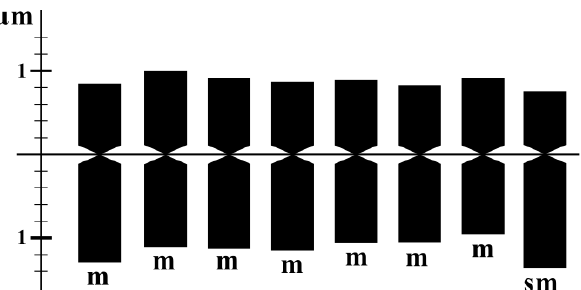
Figure 3. Idiogram of Agrimonia pilosa Ledebour (Beijing, China), 2 n = 16. m – metacentric chromosome, sm – submetacentric chro- mosome.